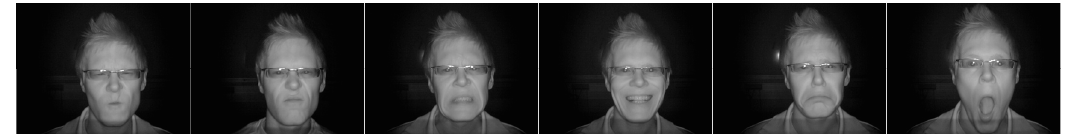
Figure 2. Anger, disgust, fear, happiness , sadness, surprise images of one person in apex condition of Oulu-CASIA NIR facial expression database.